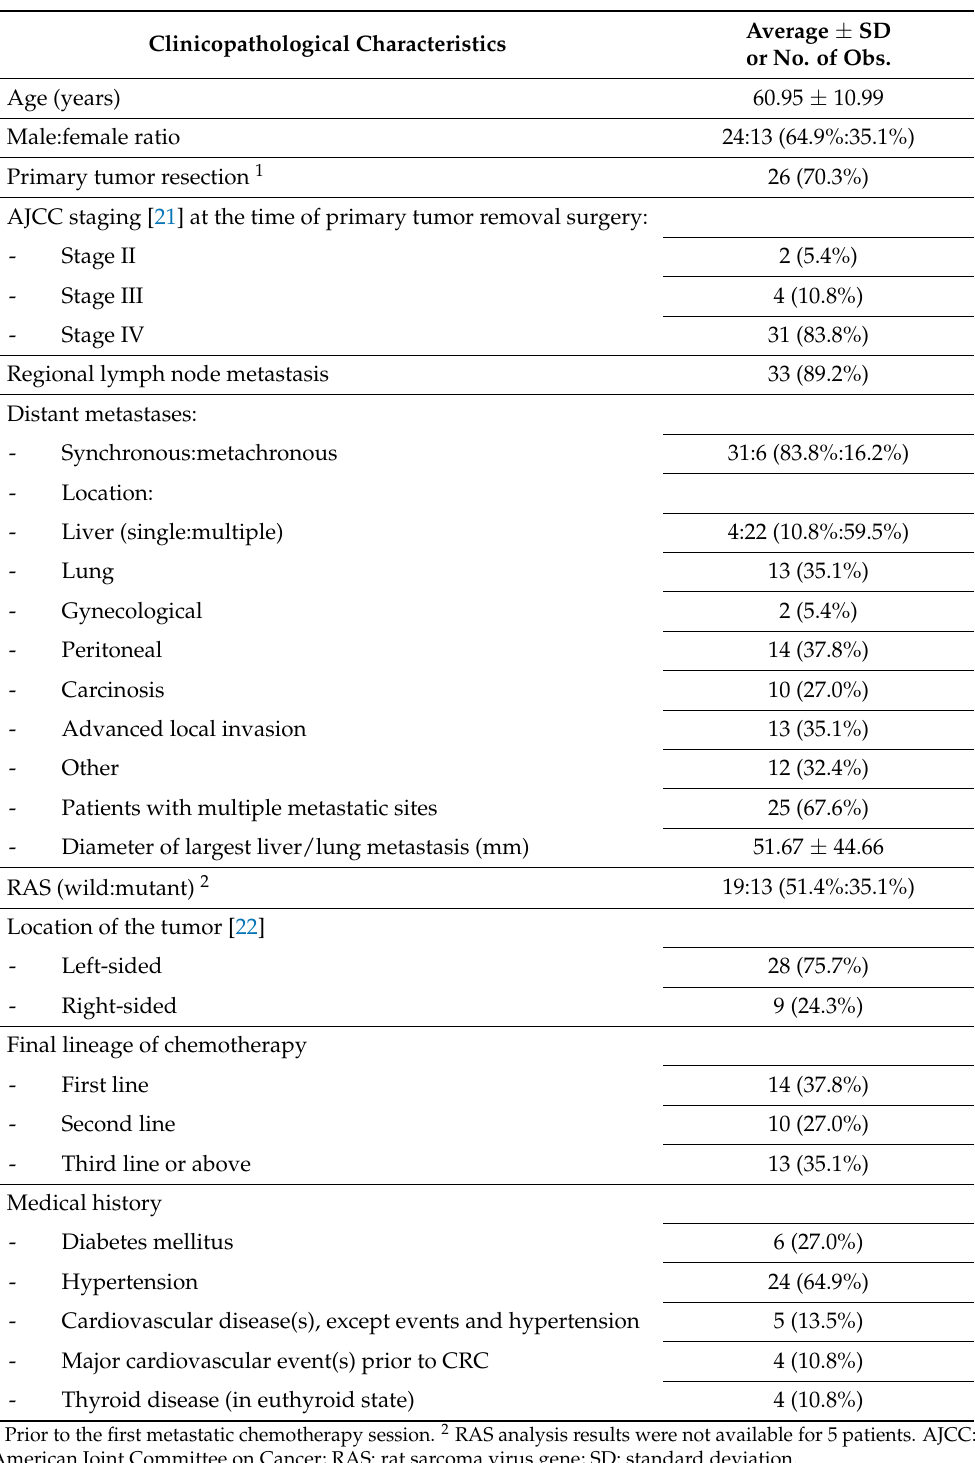
Table 1. Baseline anamnestic data of study participants ( n =